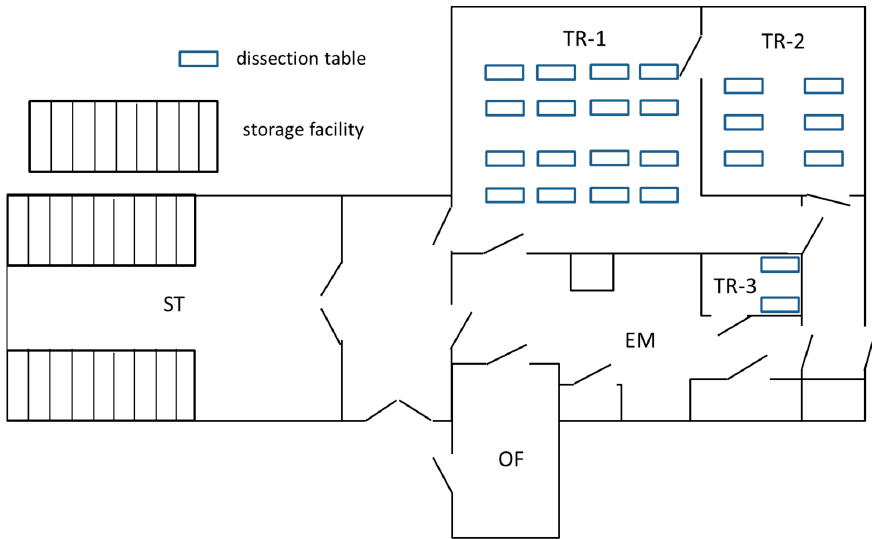
Figure 1. Lay-out of the Preparatorium. TR-1 = Teaching Room-1; TR-2 = Teaching Room-2; TR-3 = Teaching Room-3; EM = Embalming; ST = Storage; OF = Office.